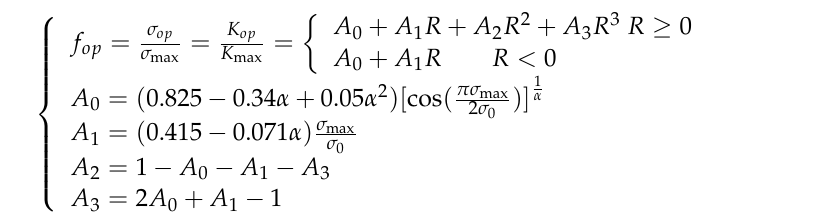
Figure 12. Equivalent model of a corrosion pit: ( a ) 3 days; ( b ) 7 days; ( c ) 15 days; ( d ) , ( e ) and ( f ) 30 days.